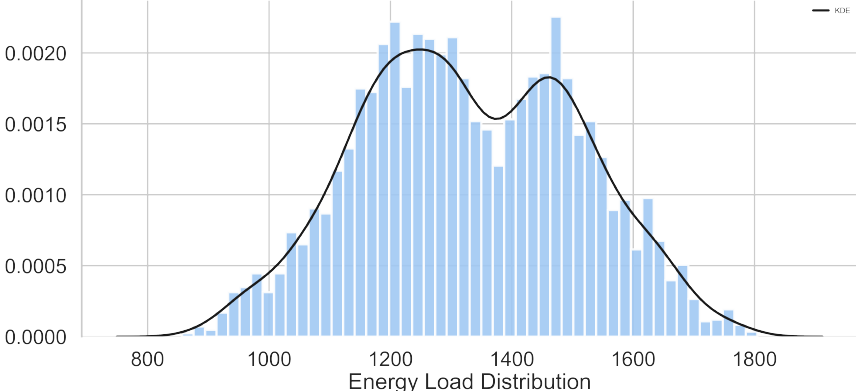
Figure 4. Energy Load histogram and the KDE curve. The x-axis groups the energy charge (in GWh) into bins, while the y-axis quantifies the resulting probability density values, i.e., a normalized